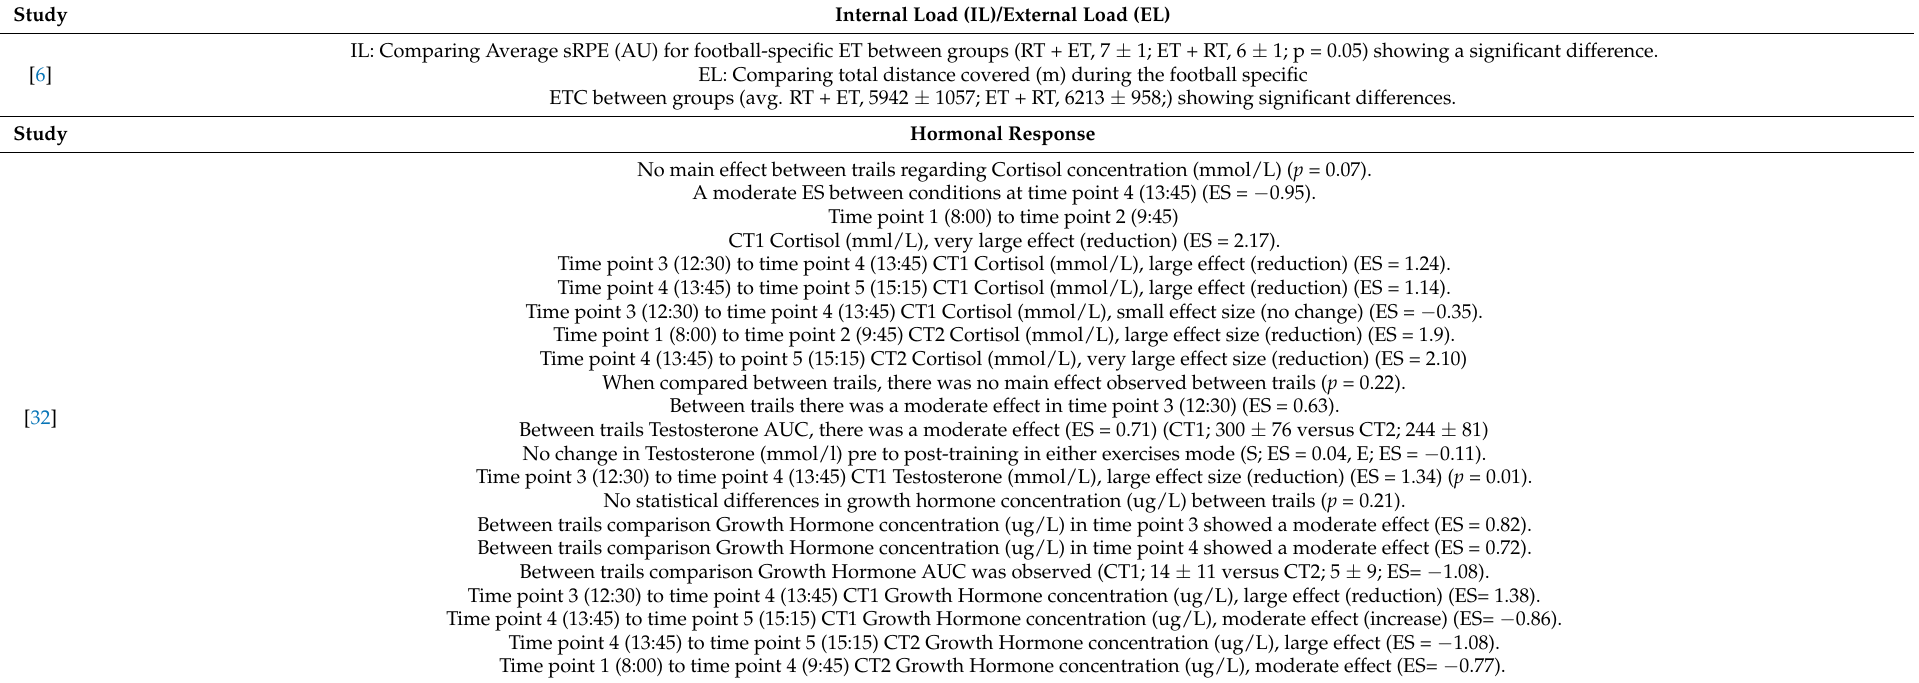
Table 6. Qualitative synthesis and summary measures considering the acute effects of concurrent training